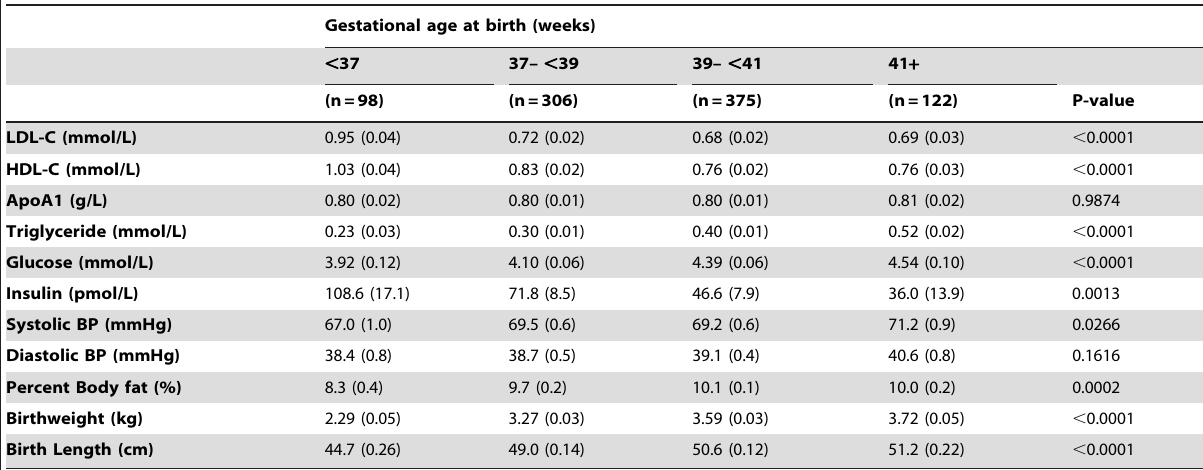
Gestational age at birth